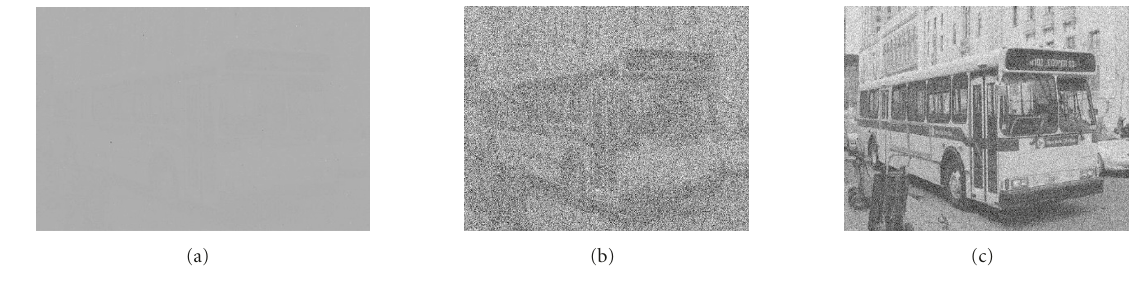
Figure 6: (a) Sample share; (b) decryption using t = 10 shares; (c) decryption using 40 shares.